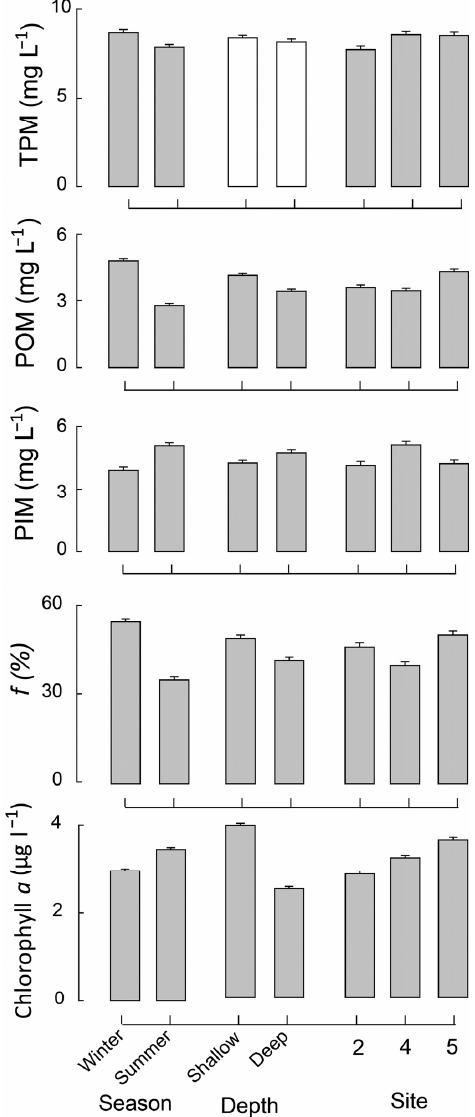
Figure 3. Mean (+SE) of total particulate matter (TMP), particulate organic matter (POM), particulate inorganic matter (PIM), quality of seston ( f ), and chlorophyll a of the water sampled in the different seasons, depths, and sites in the basin of the Swan-Canning Estuary. Bars were shaded grey when the levels within a factor were statistically significant from each other.